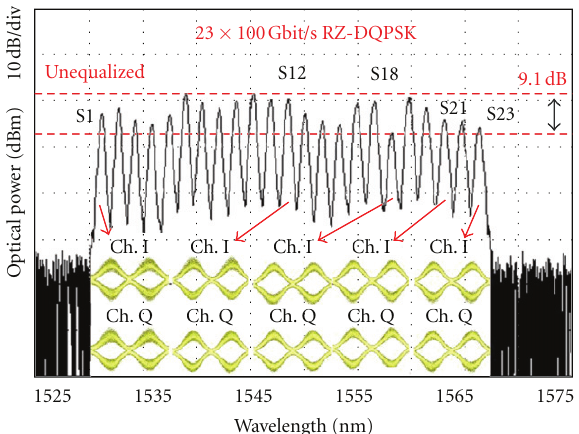
Figure 26: Measured spectrum and balanced eyes for input unequalized 23-channel 100 Gbit/s RZ-DQPSK signals.